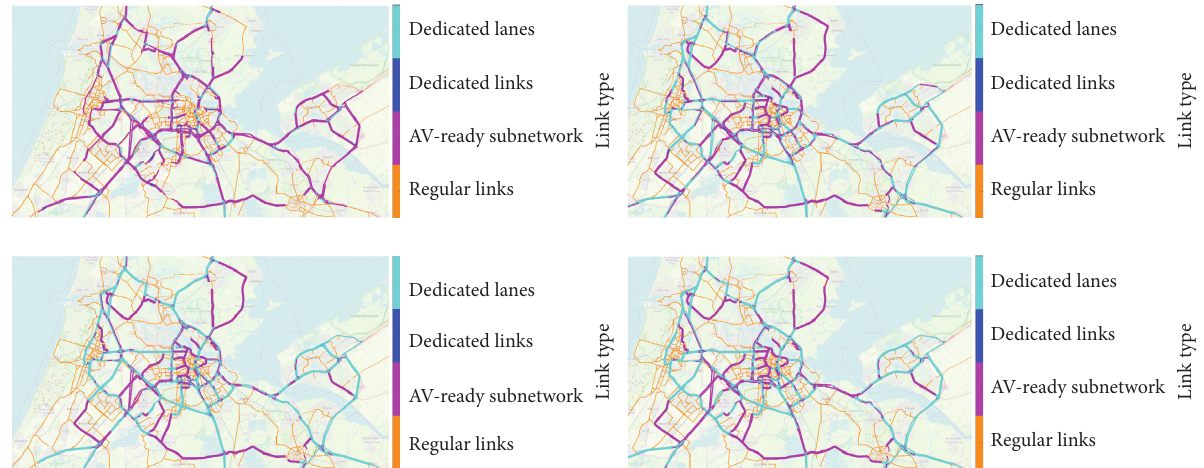
Figure 5: AD subnetworks obtained by the evolutionary heuristic solution for the Amsterdam case study. (a) 10% MPR. (b) 30% MPR. (c) 50% MPR. (d) 90% MPR.